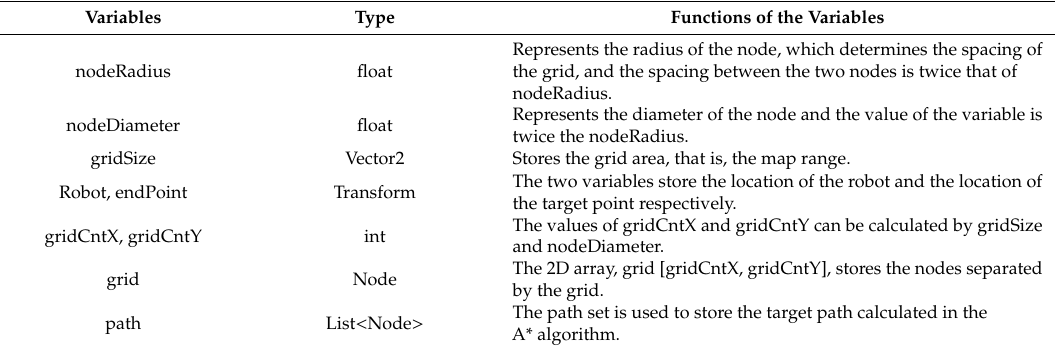
Table 7. Variables of data members of the program grid.